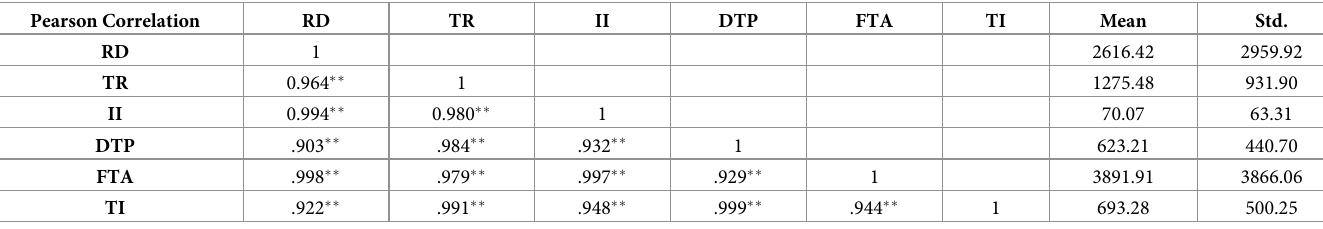
and α in Table 6, the intrinsic 10 20